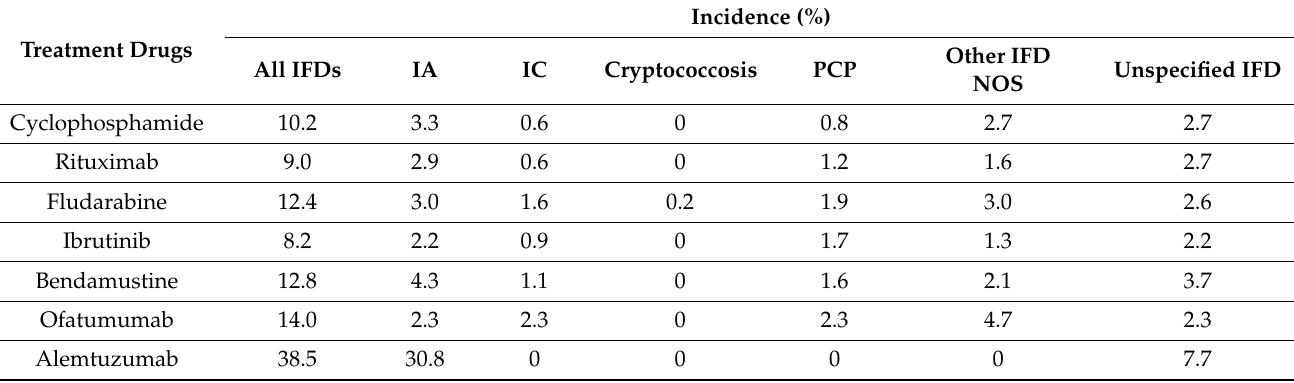
Table 4. Incidence of IFDs in patients treated with each treatment drug for CLL.